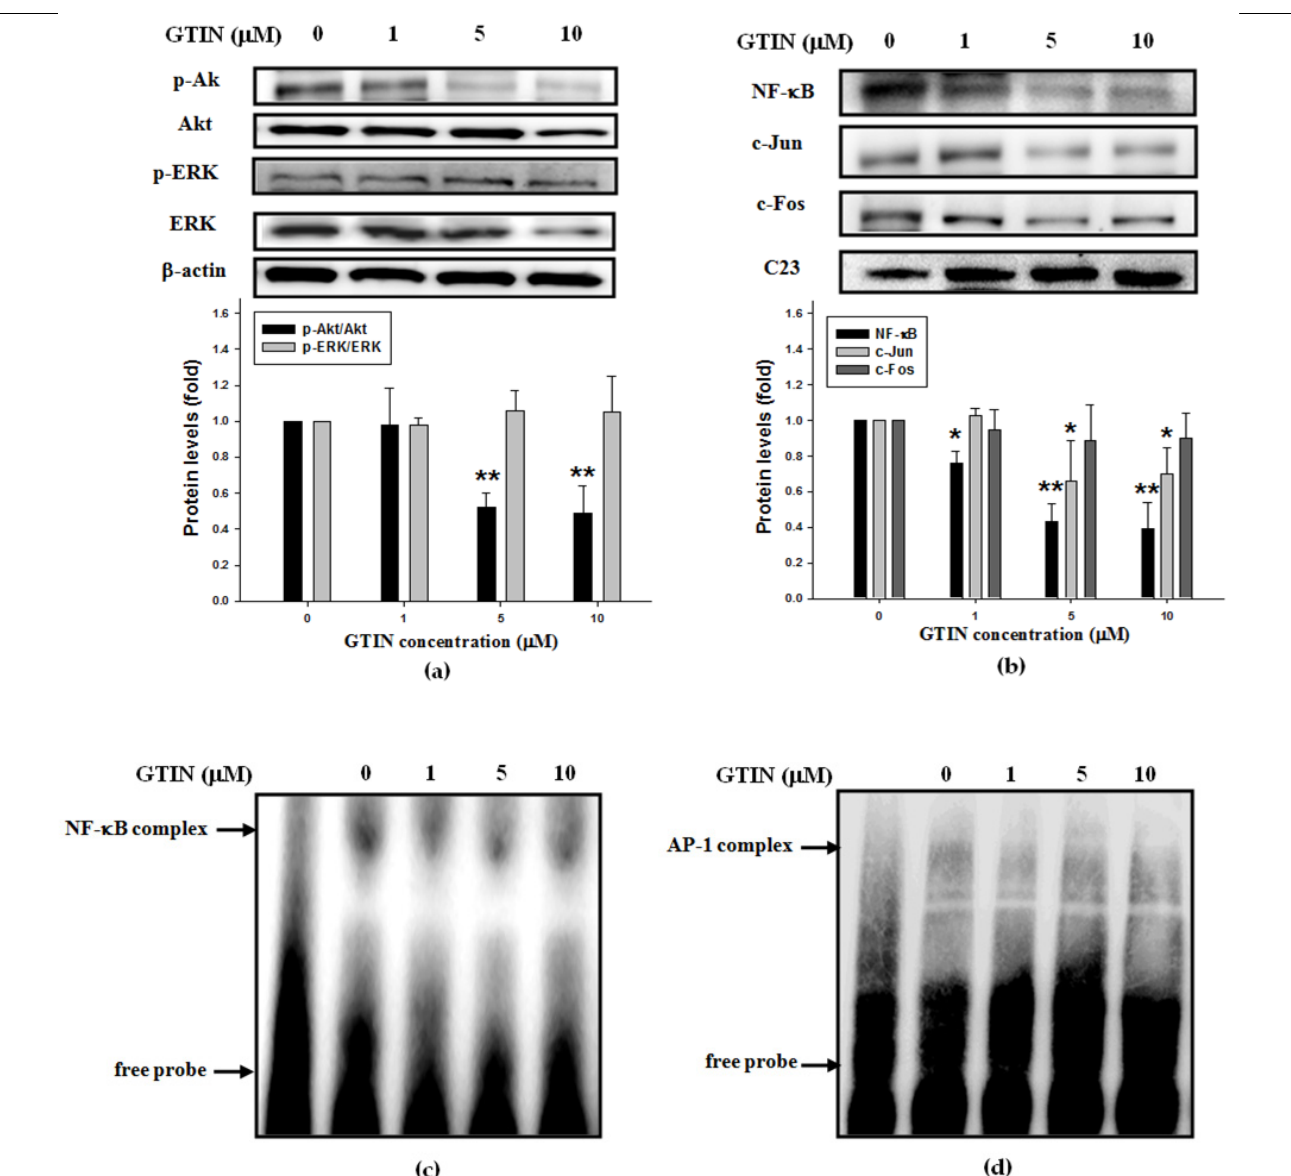
Figure 5. GTIN regulated Akt/NF- κ B signaling pathways in VSMCs. A7r5 cells were incubated with GTIN at the indicated doses (0, 1, 5 and 10 µ M) for 48 h. ( a ) The cytoplasmic levels of p -Akt, Akt, p -ERK, ERK and β -actin, as a cytosol internal control, were assayed by WB. ( b ) The nuclear levels of NF- κ B, c-Jun, c-Fos and C23, as a nuclear internal control, were assayed by WB. The quantitative data was presented as means ± SD of three repeats from three independent studies. * p < 0.05, ** p < 0.01 compared with the untreated control via one-way ANOVA with Dunnett’s post-hoc analysis. ( c ) The DNA-binding abilities of nuclear NF- κ B ( c ) and AP-1 ( d ) were analyzed using EMSA method. For the binding specificity controlling, Lane 1 represented the nuclear extracts reactive to free probe (the so-called unlabeled oligonucleotide). The results of EMSA were showed at least three independent experiments.